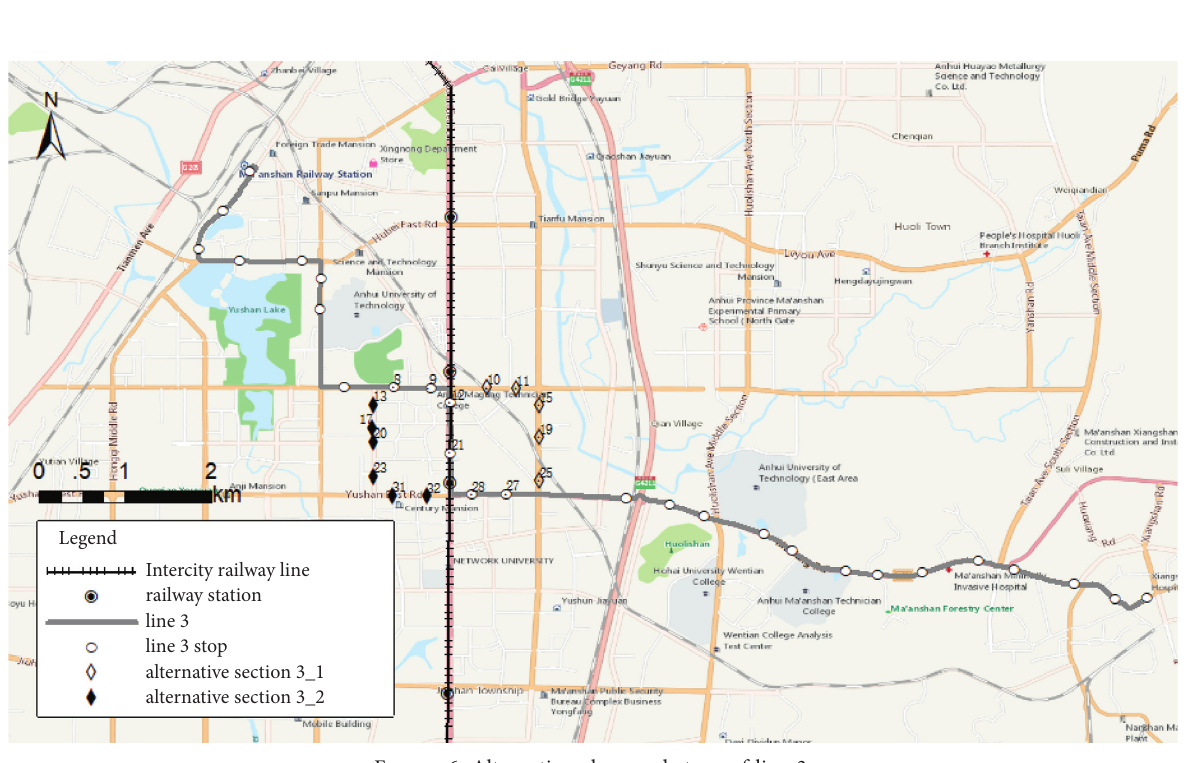
Figure 6: Alternative plans and stops of line